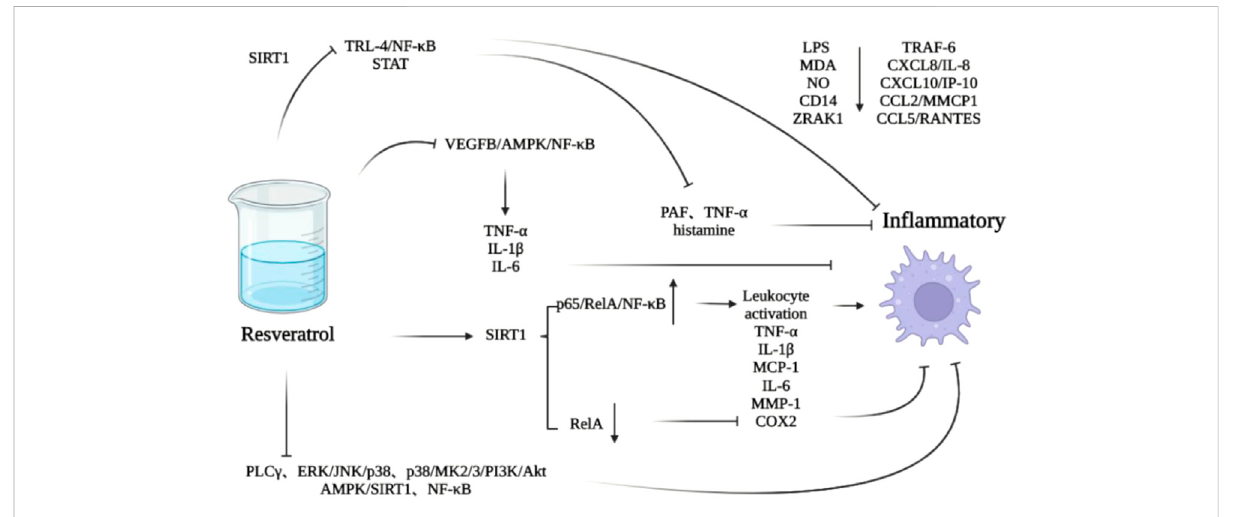
FIGURE 3 Effect of resveratrol on macrophage mediated in fl